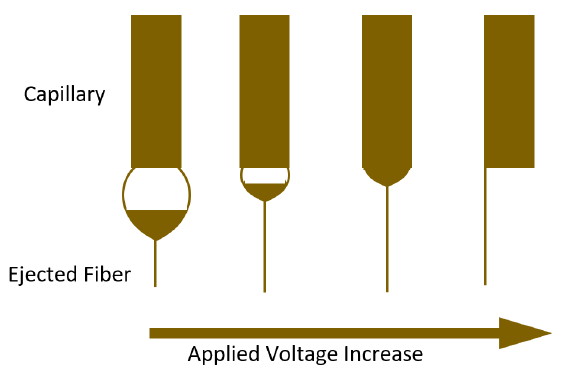
Figure 9. Influence voltage on the Taylor cone creation. At low voltage, a pendant droplet (white) is produced at the capillary tip while a Taylor cone (dark blue) is produced at the pendant droplet tip. By enhancing voltage, a Taylor cone is produced at the capillary tip, and then further voltage results in the ejection of the fiber jet through the capillary.